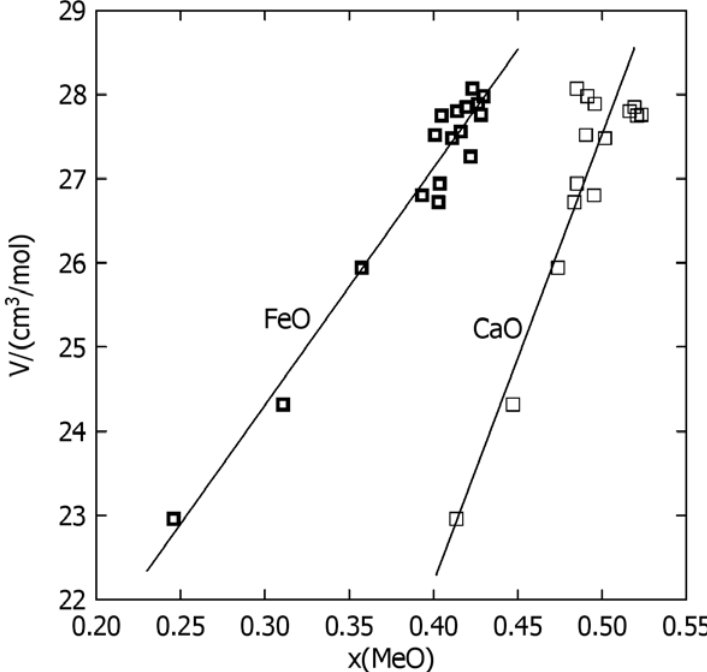
Fig. 1 Dependence of the molar volume of melts of the system CaO-FeO-Fe 2 O 3 -MgO on the content of CaO and FeO at the temperature of 1623